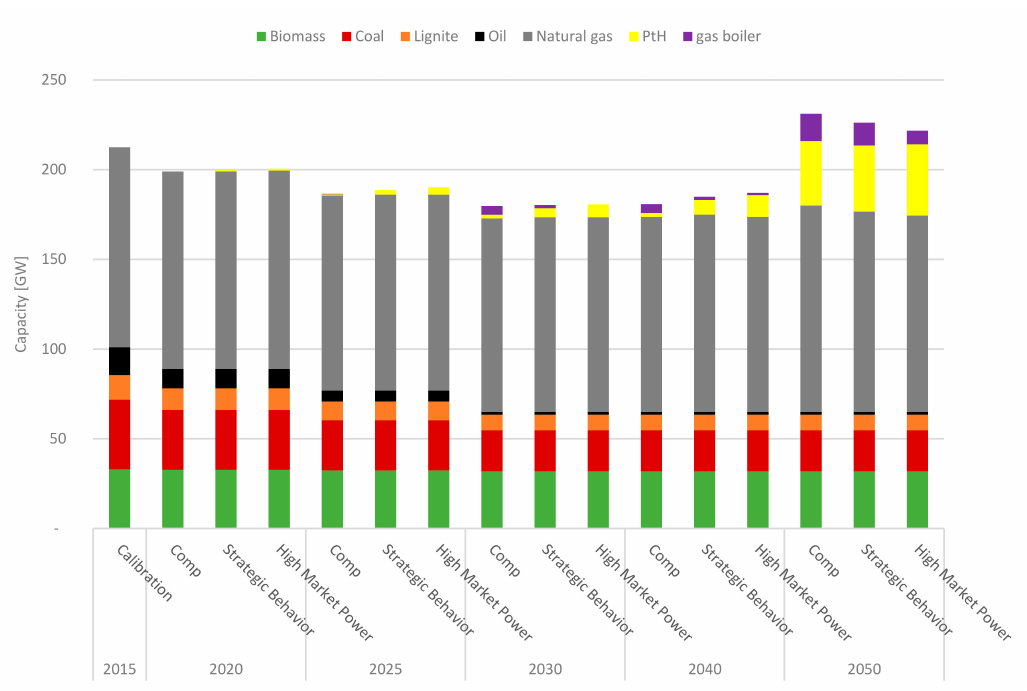
Figure 8. Developments of electricity prices for selected regions.